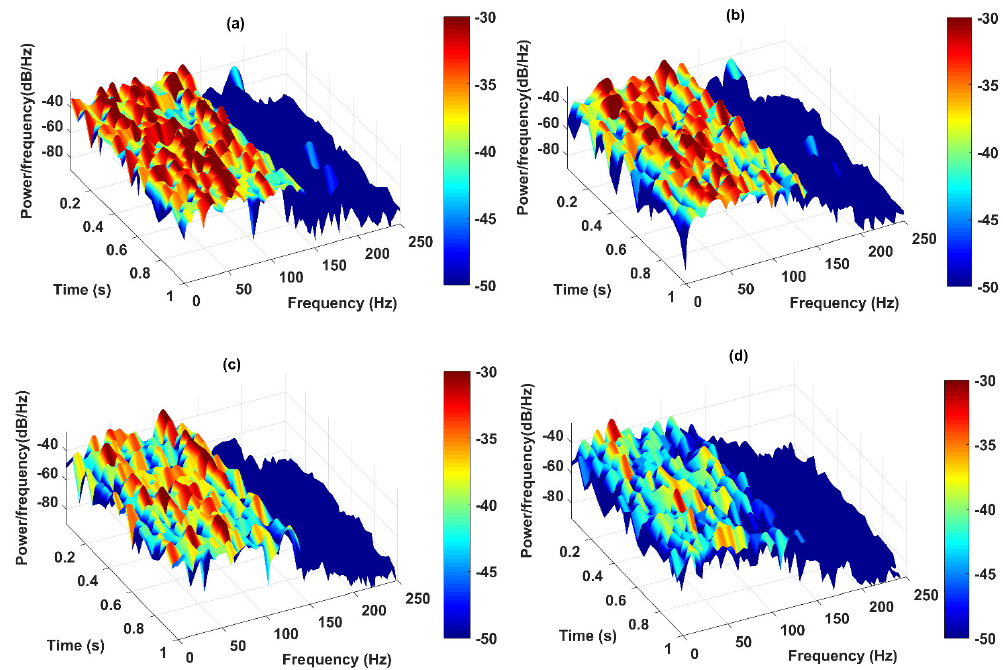
Figure 16. Spectrograms output of the IMFs for di ff erent locations of ( a ) the nearest, ( b ) second-nearest, ( c ) far, and ( d ) the farthest sensors from the 100% damaged element through the proposed model.